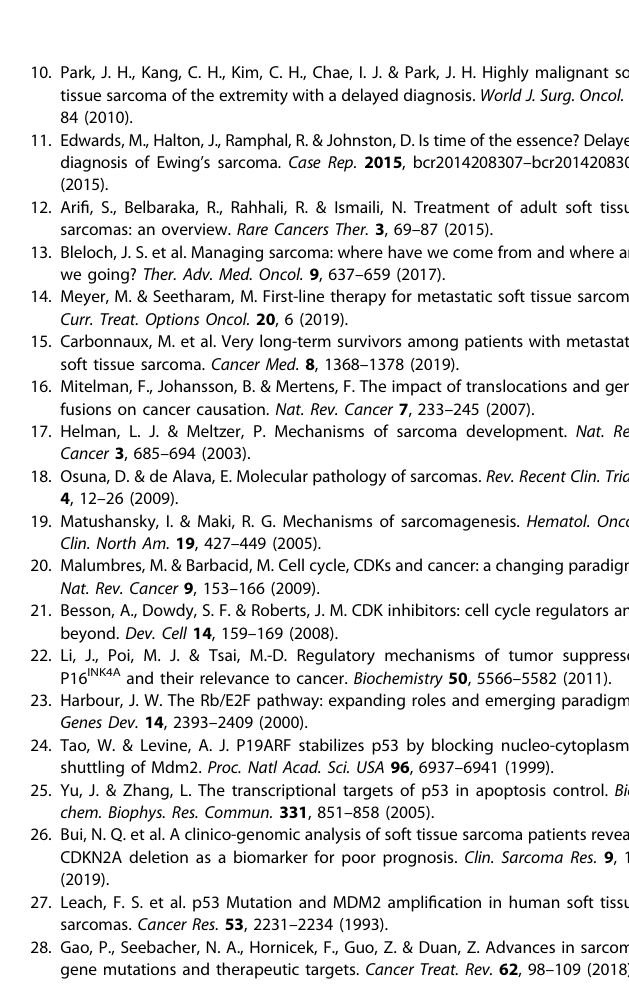
Fig. 8 Schematic illustration of personalized sarcoma treatment depicting work fl ow from sarcoma biopsy to next generation sequencing, in vitro drug screening, and patient-derived xenograft (PDX)